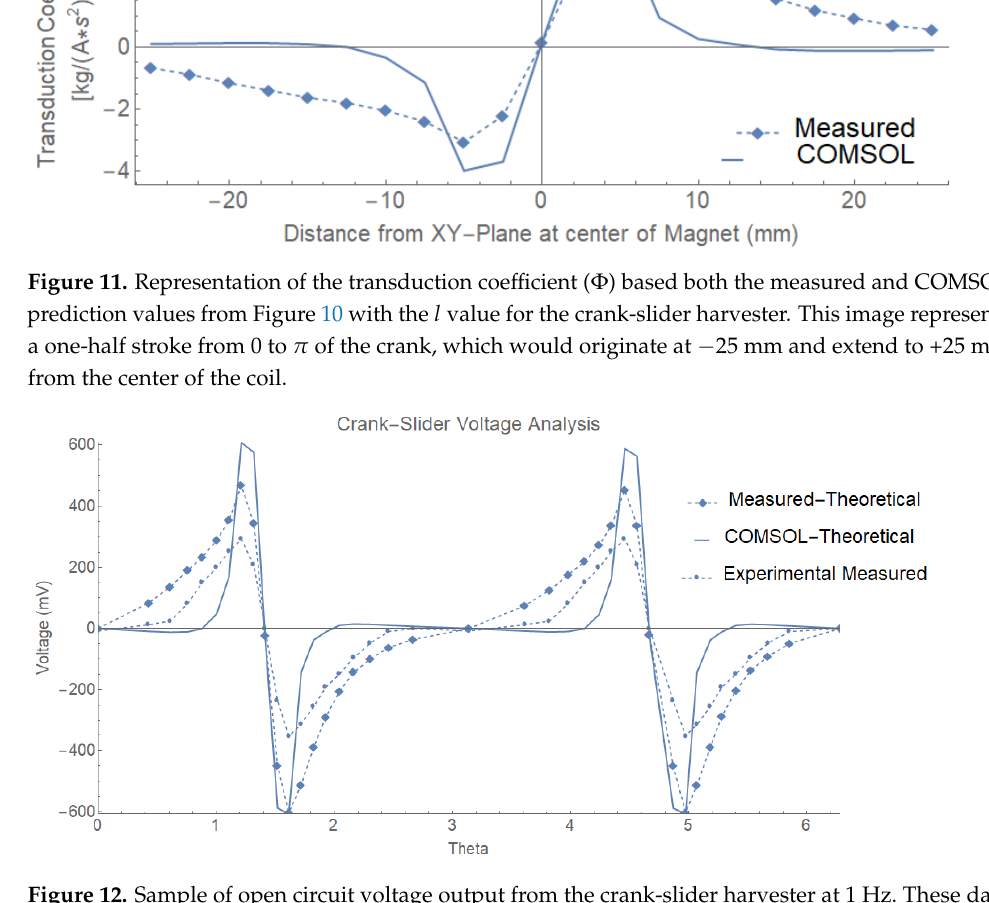
Figure 12. Sample of open circuit voltage output from the crank-slider harvester at 1 Hz. These data represent a full stroke of the crank starting at 0 and ending at 2 π , which includes 2 passes